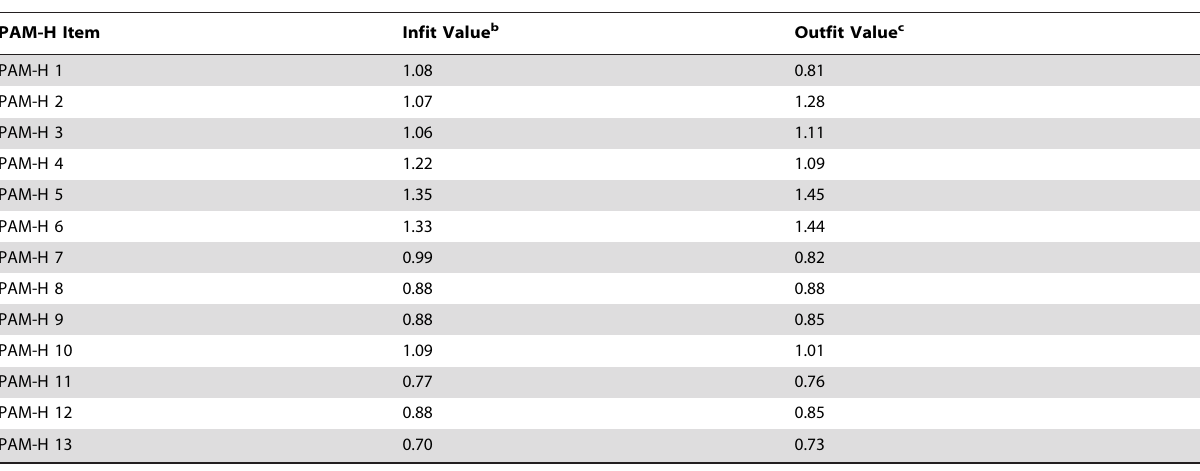
Table 2. PAM-H Item Fit Statistics (N=193) a .